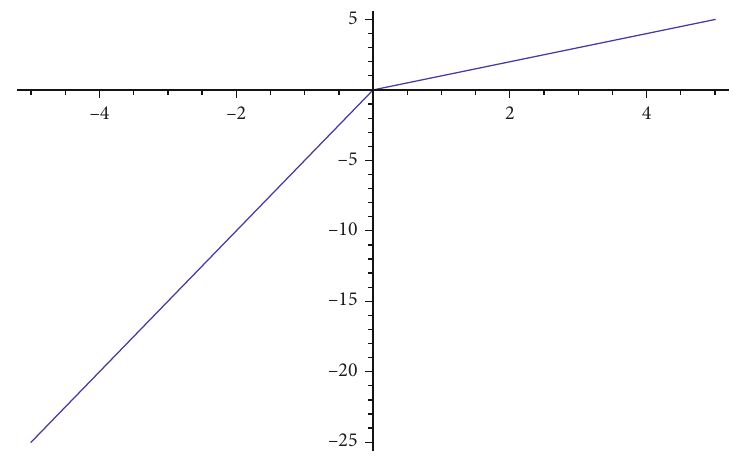
Figure 1: The activation function PReLU